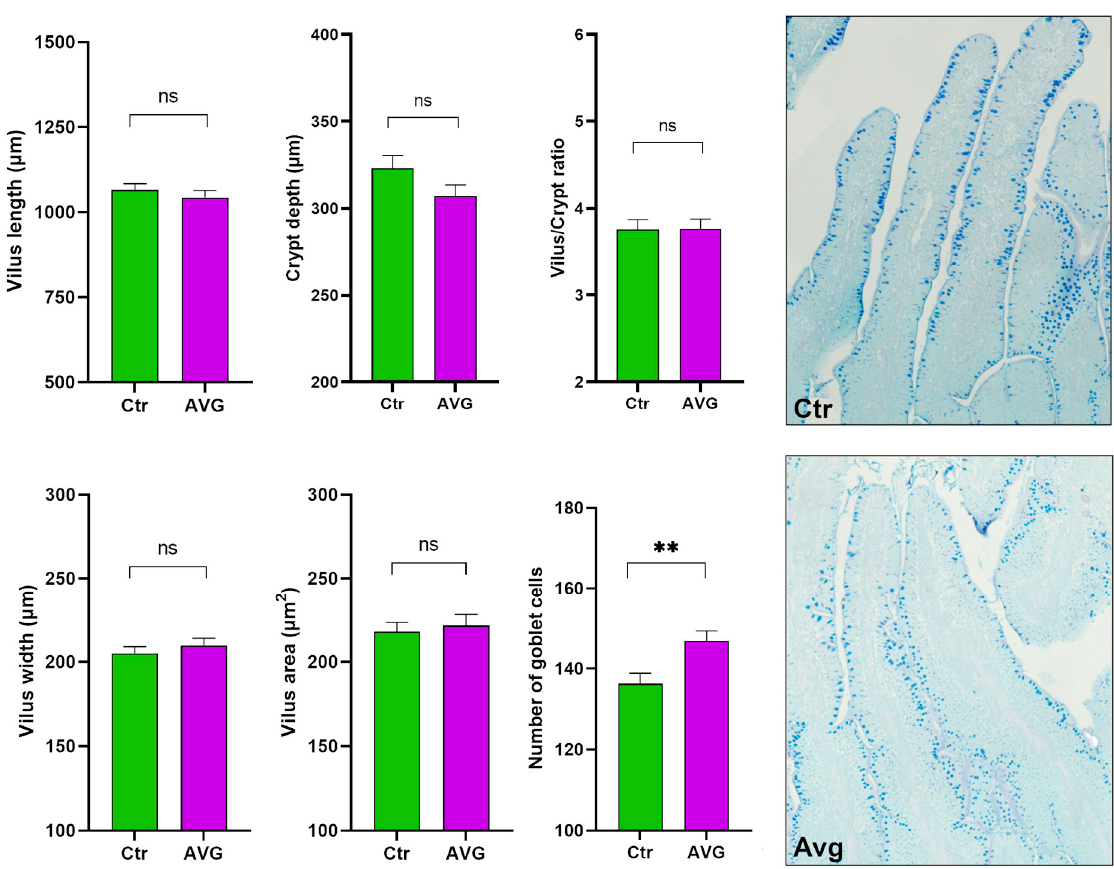
Figure 10. Histological measurements of jejunum. AVG has significantly more goblet cells. The goblet cells in AVG were smaller and noticeably more abundant in the crypt region. Both AVG and Ctr histological images are given at 20 × magnification. Significance (ns = not significant; ** p < 0.01)